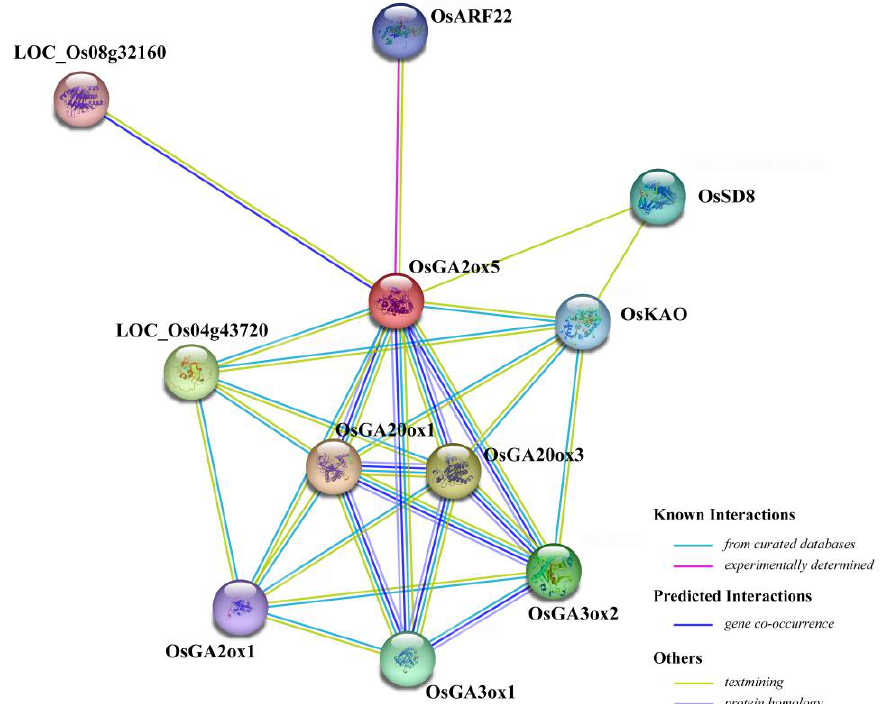
Figure 6. Schematic prediction of the proteins that might interact with OsGA2ox5. Colored lines drawn between OsGA2ox5 and other proteins indicate protein interactions, which were identified through bioinformatics and experimental methods, including known interactions, predicted interactions, textmining and protein homology. The color key in the connecting lines is shown to the bottom-right corner of the figure.